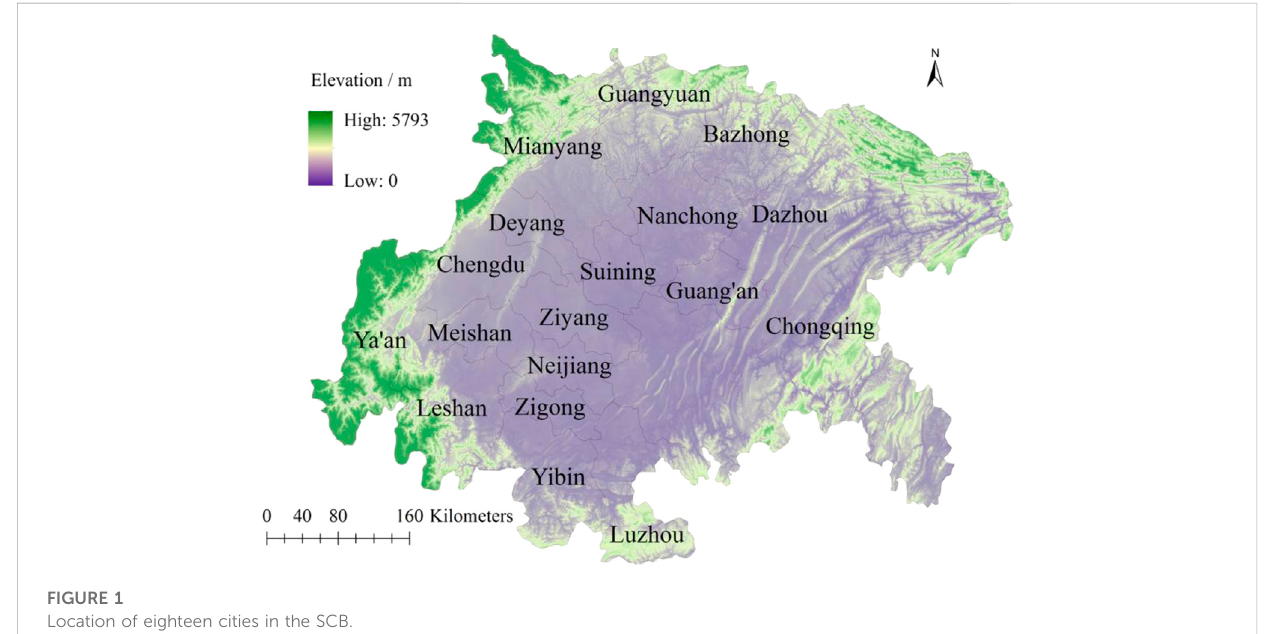
FIGURE 1 Location of eighteen cities in the